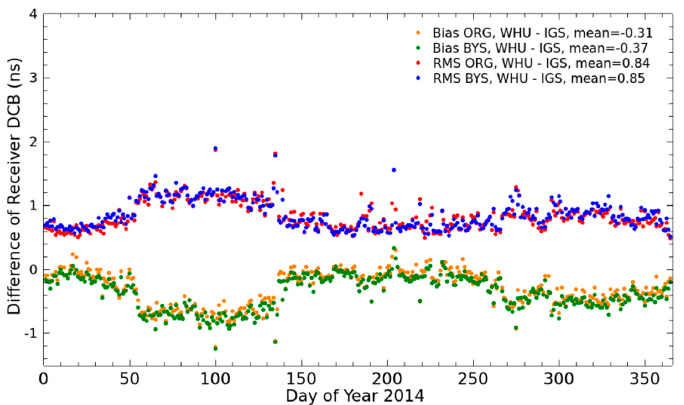
Figure 11. Differences in receiver DCBs between WHU products based on original LSE or Bayesian estimation and the IGS final combined products.